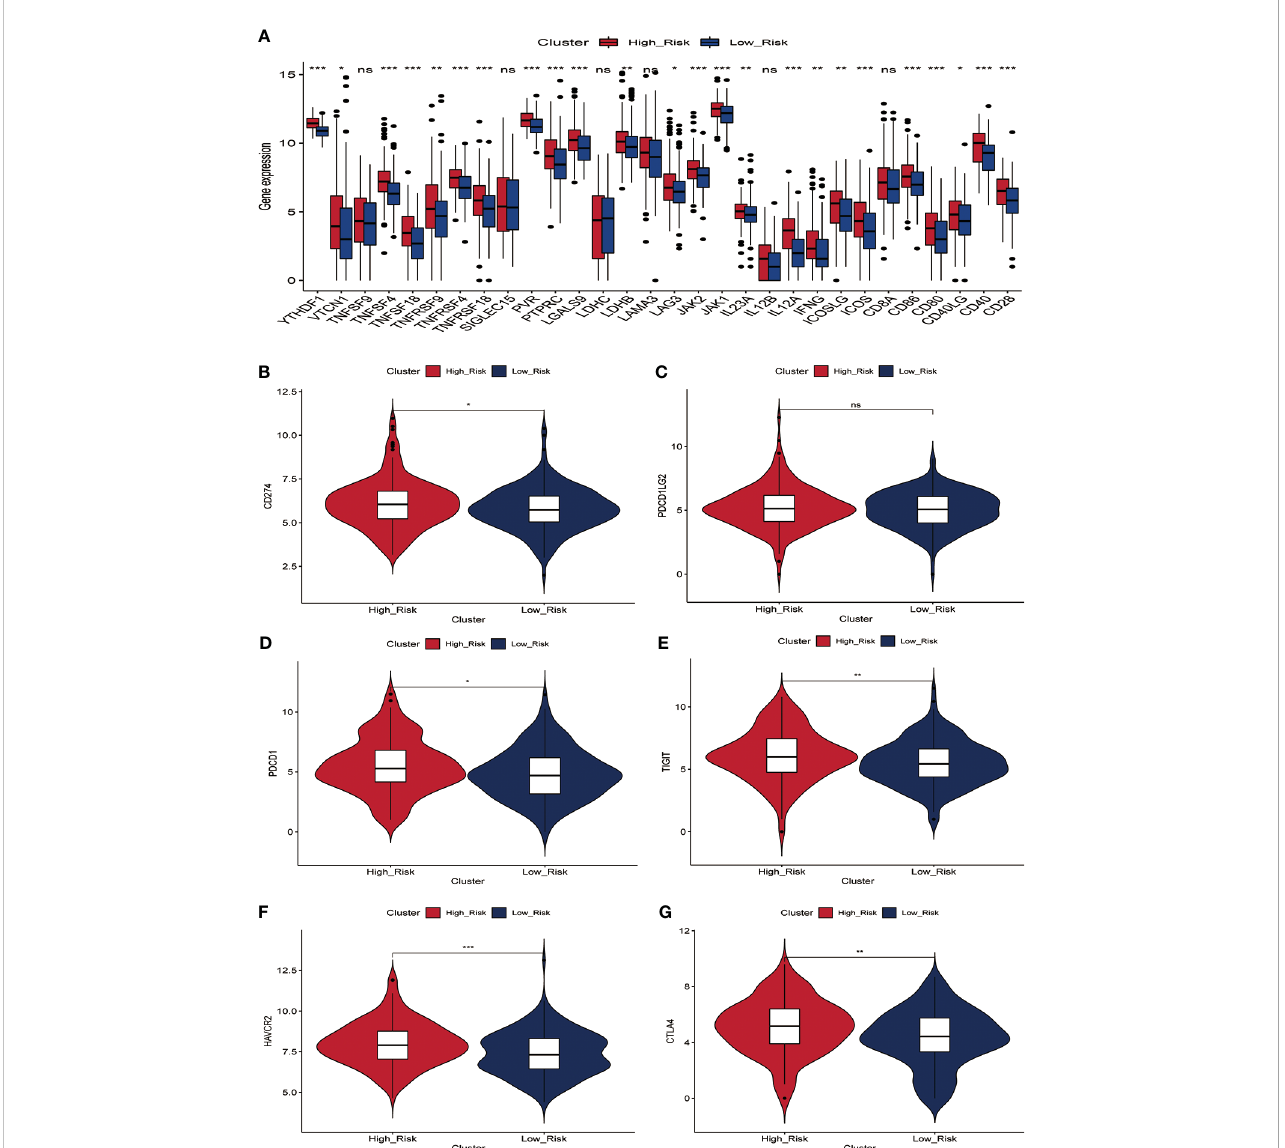
FIGURE 7 Relationship between prognostic signature and mRNA expression levels of immune checkpoint-associated genes in the training set. (A) The mRNA expression levels of most immune checkpoint-related genes were signi fi cantly higher in the high-risk group. (B-G) Differences in mRNA expression levels of six immune check-related genes commonly used in HCC immunotherapy between high- and low-risk groups, including PD-L1 (B) , PD-L2 (C) , PD1 (D) , TIGIT (E) , TIM-3 (F) and CTLA4 (G)